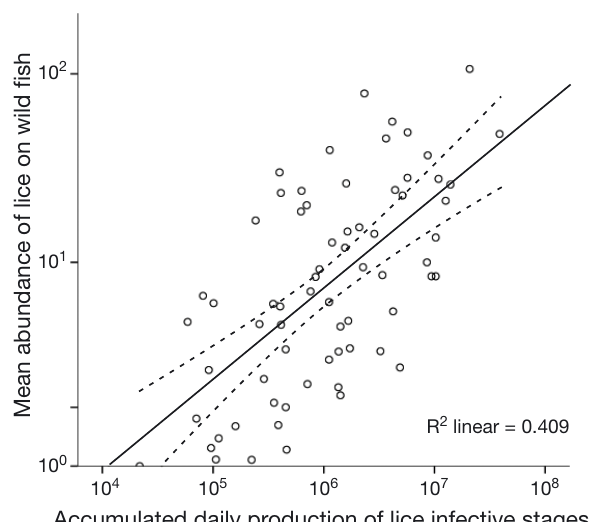
Fig. 3. Linear regression (with 95% confidence interval, dashed lines) between sea lice infection levels (mean abun- dance) on wild sea trout and estimated number of infective lice stages produced in nearby farms (r 2 = 0.409, p < 0.001, n = 71). Only farms within 30 km sea-way distance of the sampling locations are included; a simple linear down- weighting was applied to the daily production of lice at each farm to account for the distance to the corresponding